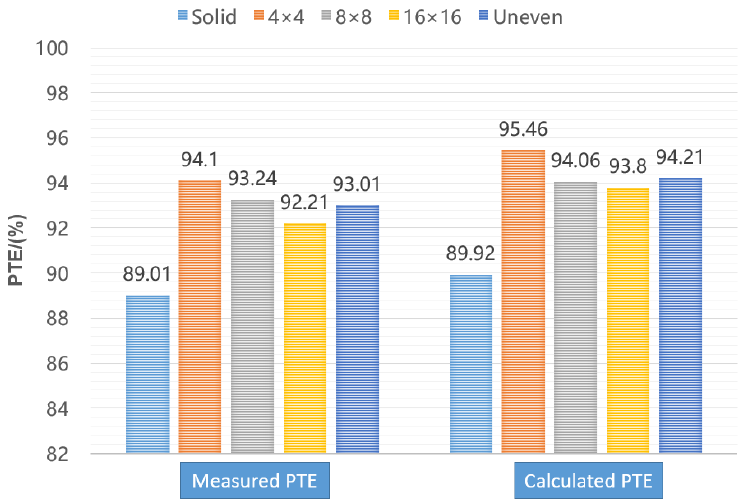
Figure 16. Comparison of transmission efficiency of the system loaded with aluminium plates of different structures.